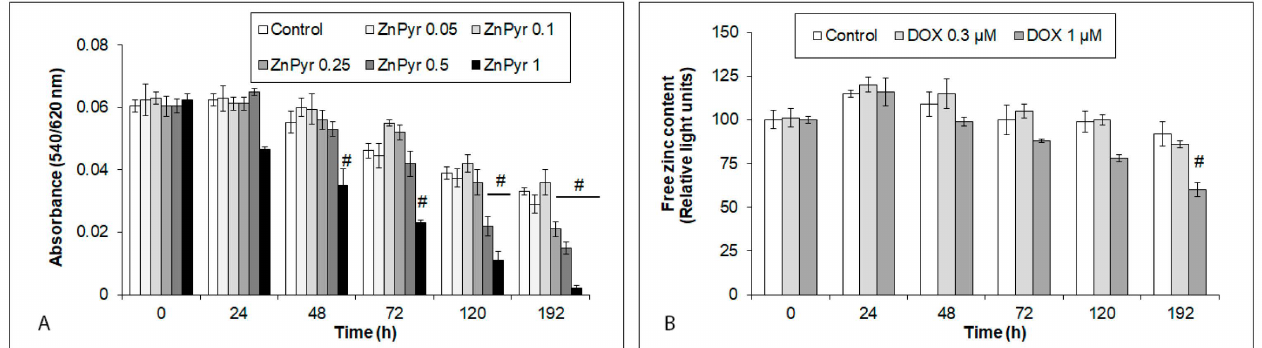
Figure 5. Effects of zinc pyrithione (ZnPyr) on viability and on free Zn levels in hiPCS-CMs over 192 h. Cardiomyocytes were exposed to a range of ZnPyr concentrations (in µ M) and their viability was measured by neutral red uptake assay (NRU) (Section 4). Free zinc content in control and 0.3 µ M and 1 µ M DOX-treated cells was measured by microfluorometry of the zinc-specific dye Newport Green diacetate, as described in Section 4. Values represent means ± SD of N = 4 experiments. # p < 0.05 compared to untreated control cells at the same treatment interval with one-way ANOVA test and Dunnett’s post test for multiple